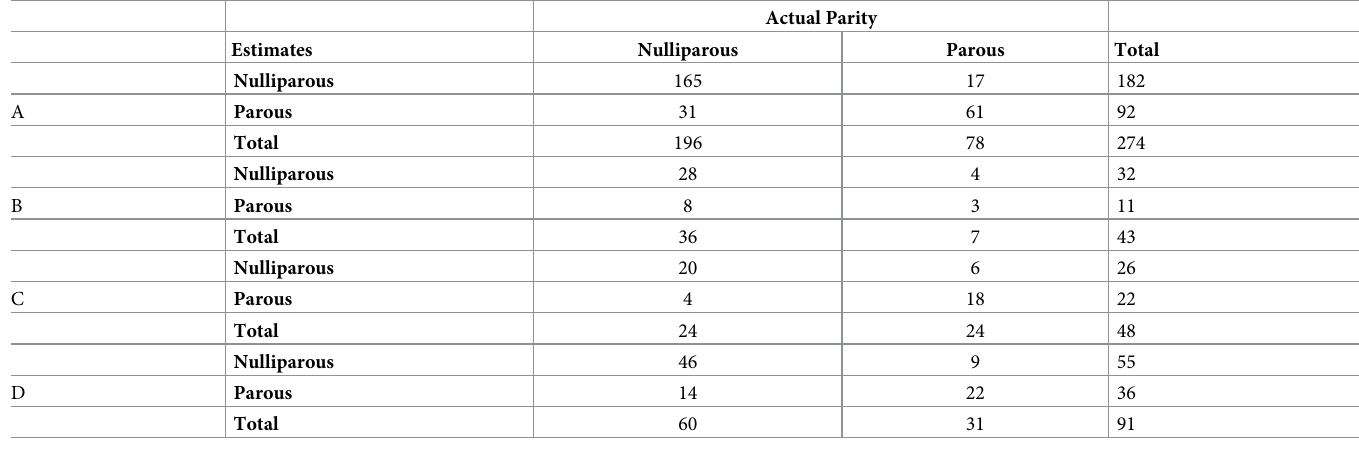
Table 3. Confusion matrices showing accuracies of the models in absolute values when the models were trained on spectra before feature reduction by autoencoder. A) Minepa-ARA, B) Muleba-GA, C) Burkina-GA and D) Muleba-Burkina-GA. Results from the last Monte-Carlo cross validation. Actual Parity Estimates Nulliparous Parous Total